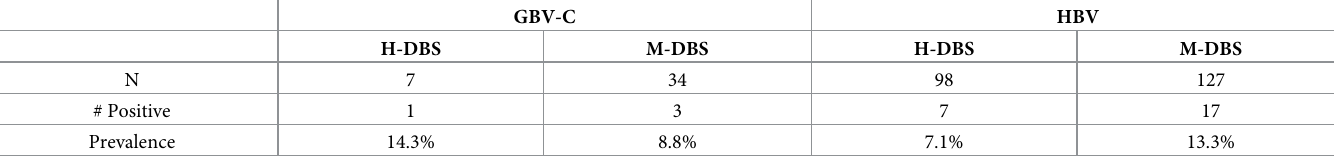
Table 3. Prevalence of human viruses by